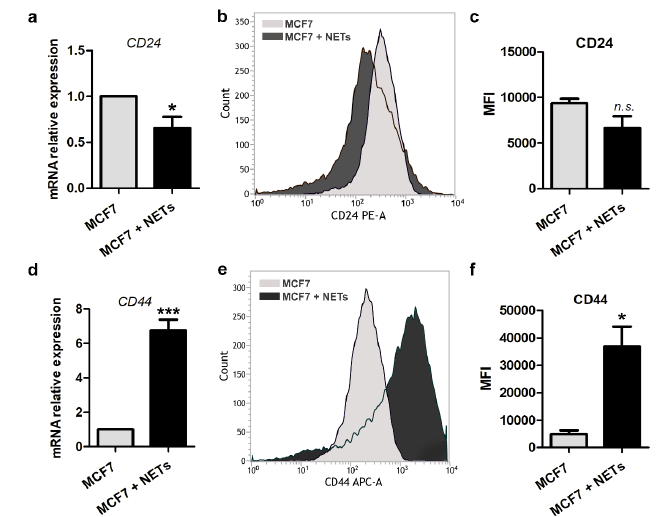
Figure 3. Cancer stem cell markers are regulated by NETs. Gene expression of CD24 ( a ) and CD44 ( d ) was analyzed by quantitative RT-PCR in MCF7 cells that were cultured for 16 h in the absence (gray bar) or the presence (black bar) of NETs (500 ng/mL). GAPDH was used as the reference gene. The relative expression level of the mRNA was calculated using the ΔΔCT method. Values represent means ± SD of three independent experiments. Representative histograms of flow cytometry analysis of CD24 ( b ) and CD44 ( e ). Graphic representation of relative mean of fluorescence intensities (MFI) of phycoerythrin (PE)-labeled CD24 antibody ( c ) and allophycocyanin (APC)-labeled CD44 antibody ( f ). Data shown are from two independent experiments. Unpaired t -test was applied for statistical analysis. Significance was assumed for * p < 0.05, *** p < 0.001; n.s. , no significance.